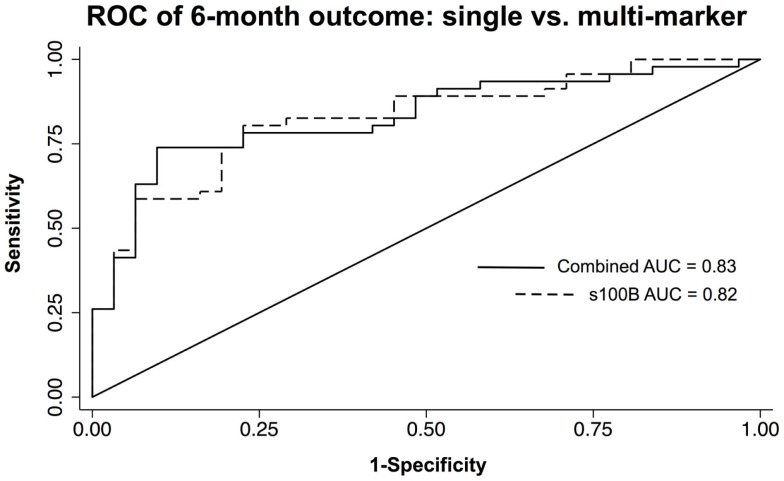
ROC curves of neuroinjury biomarkers used to discriminate unfavorable versus favorable 6-month neurological outcome in TBI patients. A combined AUC consisting of s100B, GFAP, and MCP-1 was not statistically better than s100B alone in discriminating unfavorable from favorable outcome by chi-squared.